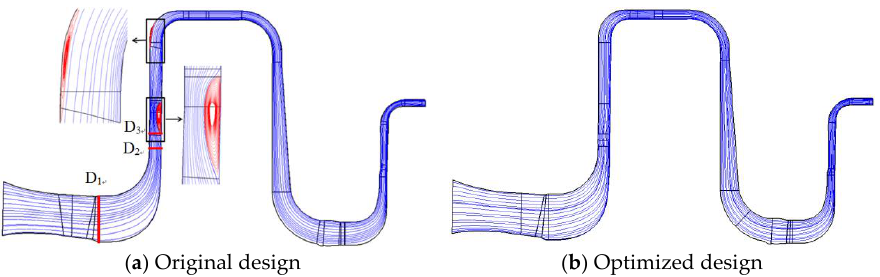
Figure 17. Meridional streamline at 90% load.